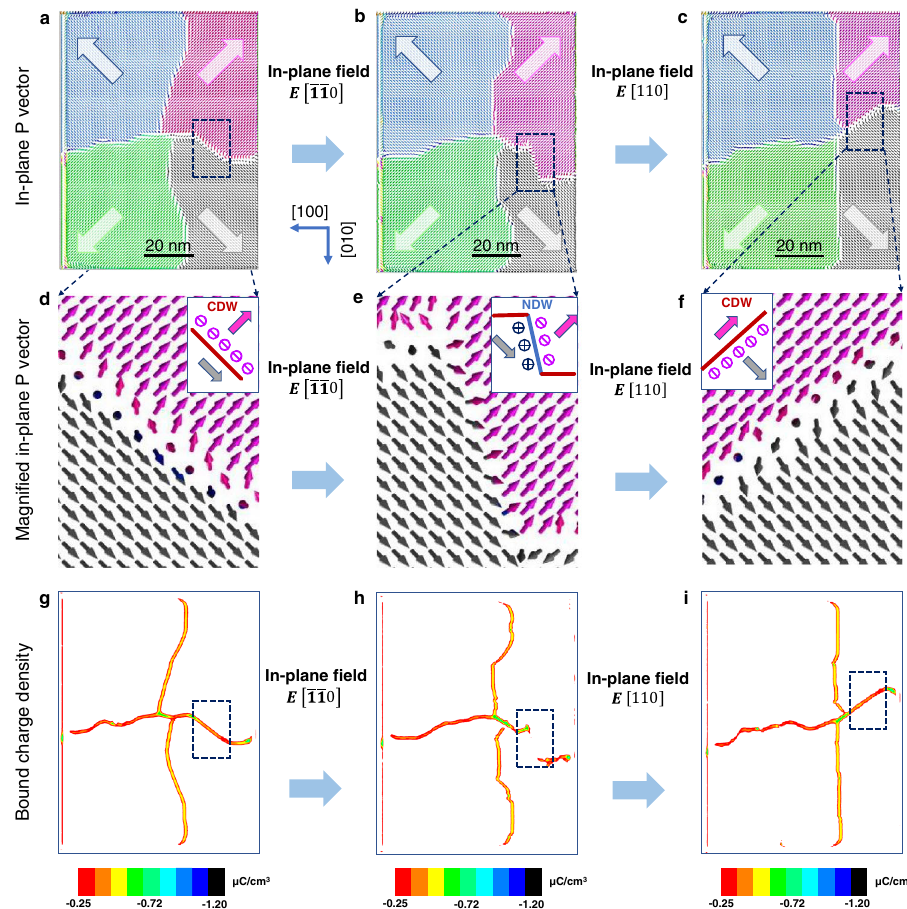
Fig. 2 Mechanism of the tunability of CDWs by an electric fi eld based on phase- fi eld simulations. a Polar vector map for a 178 × 138 nm 2 nano-island with cross-shaped CDWs. b , c Polar vector maps for the rectangular nano-island after a [ (cid:1) 1 (cid:1) 10]- or [110]-oriented electric fi eld is applied in the area enclosed by the blue dotted box in ( a ). d – f Magni fi ed polar vector maps for the area highlighted by the blue dotted boxes in ( a , b , c ), which show that the local DW is reversibly modulated between a CDW and a neutral DW by the local electric fi eld. g – i Corresponding charge density maps for ( a , b , c ). The connected CDWs in ( g ) and ( i ) and disconnected CDWs in ( h ) indicate a high conductance for the CDW and a low conductance for the neutral DW,